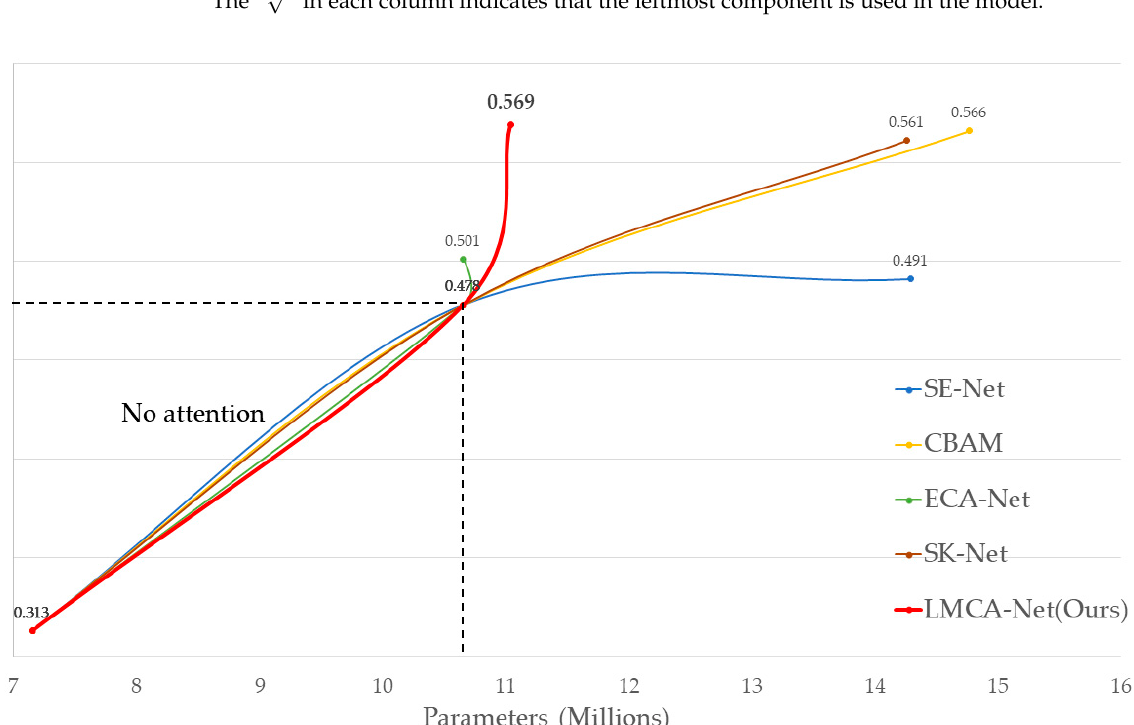
√ The “ ” in each column indicates that the leftmost component is used in the model.